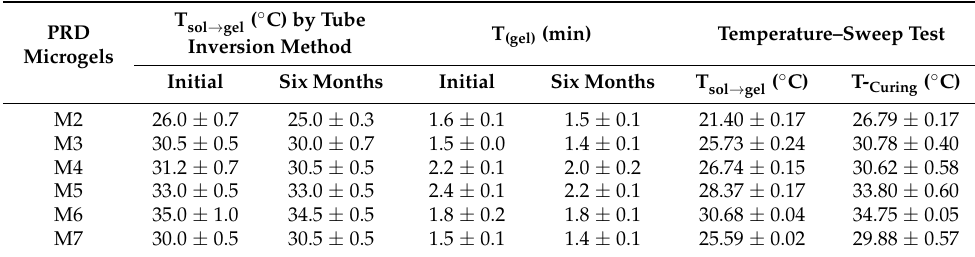
Table 9. Sol–gel transition temperature (T sol → gel ) determined by the tube inversion and temperature– sweep methods, gelation time (T (gel) ) , curing temperature (T Curing ) determined by the temperature–sweep method, and T sol → gel and T (gel) of the PRD microgels after six months of storage at room temperature. Data are presented as mean ± SD ( n = 3). T sol → gel ( ◦ C) by